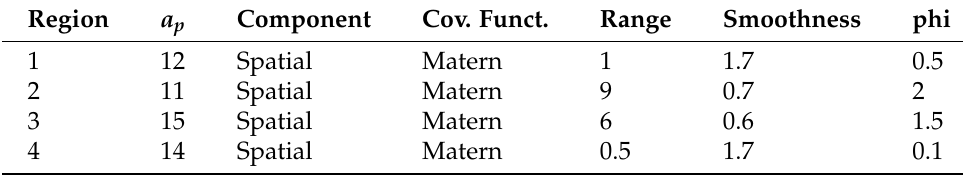
Table 2. Data generating process parameters for the spatial covariance